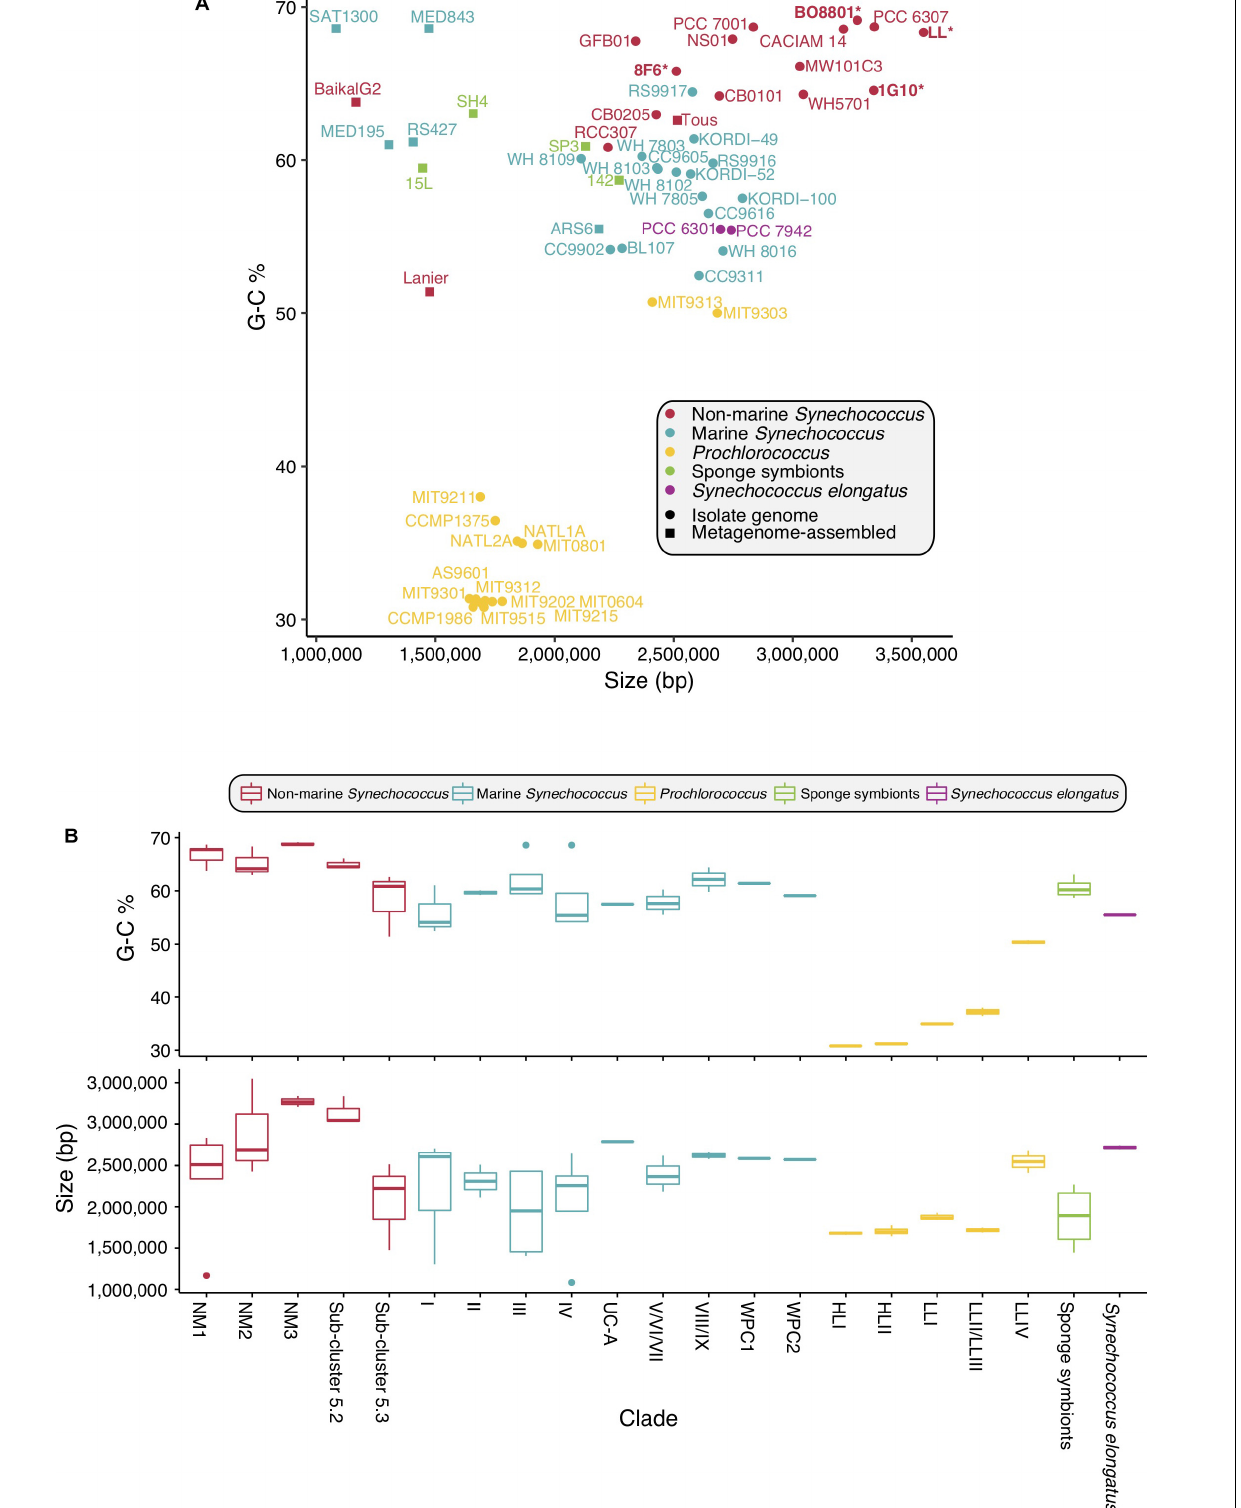
Frontiers in Microbiology |